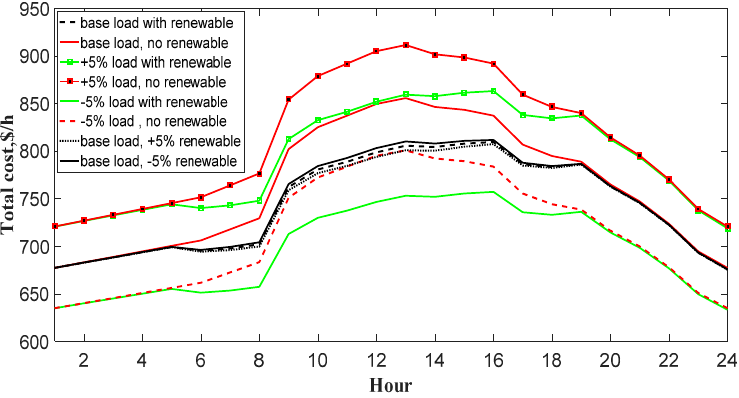
Figure 8. Cost of total generation of the system including renewable energy generation.